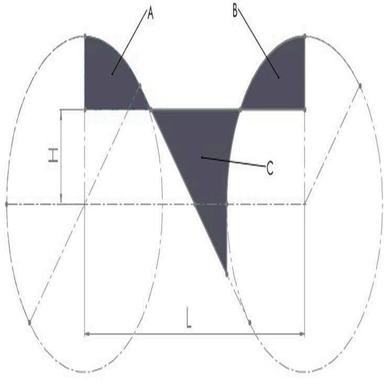
Example of areas (in grey) used for theoretical Ra calculation (based on ).